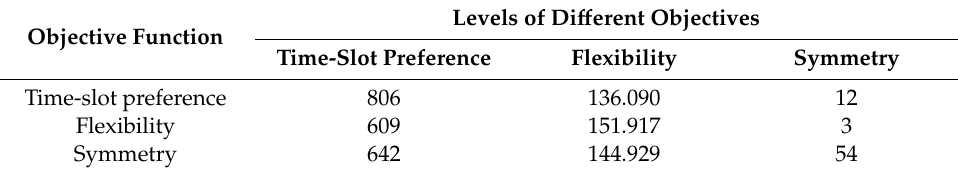
Table 1. Results of the initial runs.